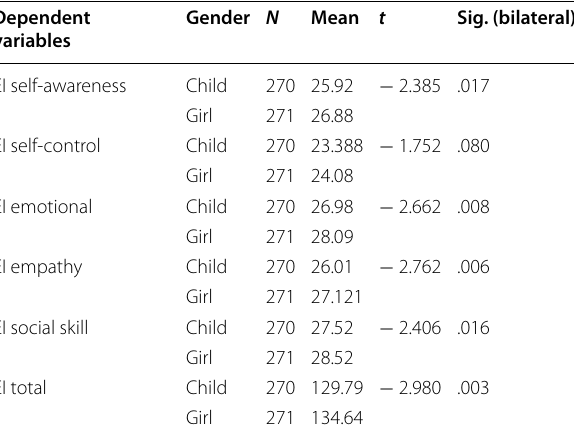
Table 4 Student’s t results for the association between gender and the different EI